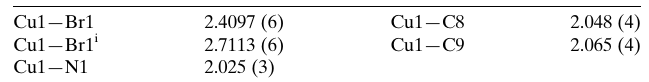
Table 1 Selected bond lengths (A˚ ) for I .